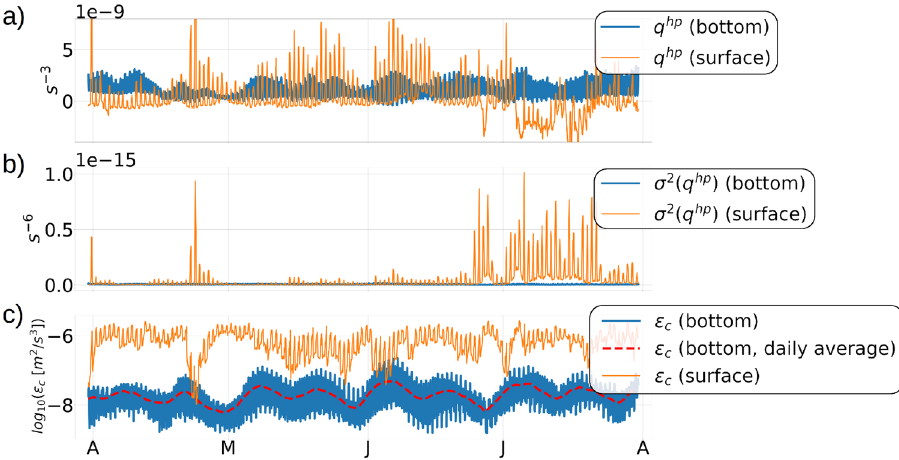
Figure 18. Hourly time series of the ( a ) high-pass filtered potential vorticity q hp near the surface and bottom, ( b ) variance of q hp over transect B near the surface and bottom, and ( c ) dissipation ǫ c near the surface and bottom near the eastern edge of the Anegada island (where the depth is −320 m). The dashed red line is the daily averaged benthic dissipation.